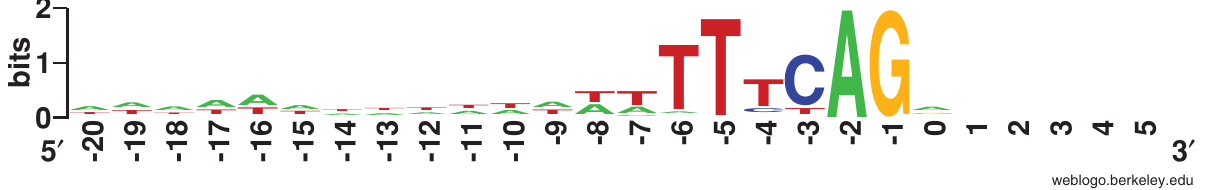
Figure 5. Sequence logo for acceptor splice sites: splice sites have quite strong consensus sequences, i.e., almost every position in a small window around the splice site is representative of the most frequently occurring nucleotide when many existing sequences are compared in an alignment. The sequence logo [72,73] shows the region around the intron/exon boundary—the acceptor splice site. In the running example, we use the region up to 40 nt upstream and downstream of the consensus site AG.